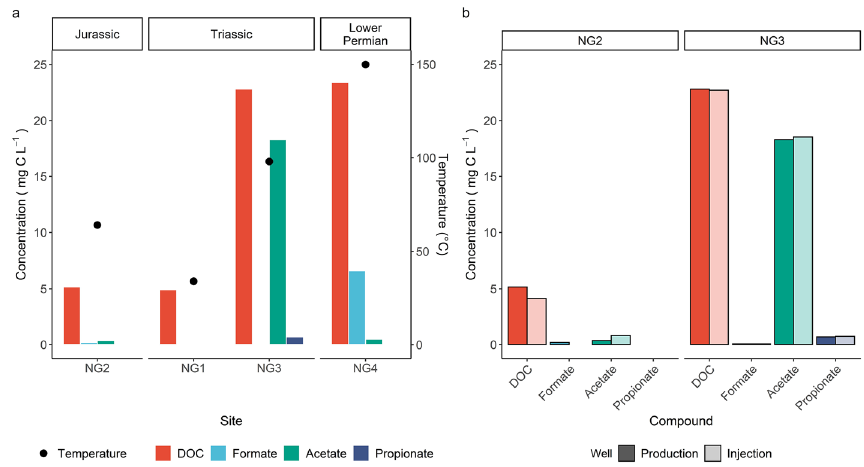
Fig. 5 a Mean concentrations of DOC, formate, acetate, propionate ( mgCL − 1 ) and the temperature for each reported site of the North German Basin. The sites on the x‑axis are arranged primarily after reservoir age (youngest to oldest from left to right) and secondarily after the well depth (shallowest to deepest from left to right) within the grouped rectangles. b Mean concentrations compared between production (dark fill)